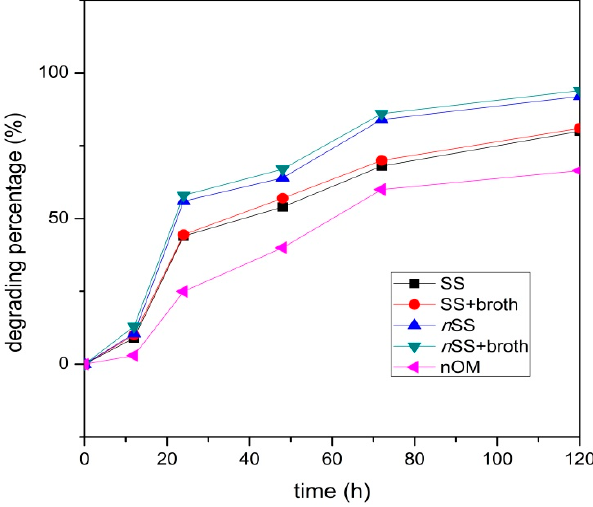
Figure 6. The influence of extra carbon and organic matter on the biodegradation of UDMH.